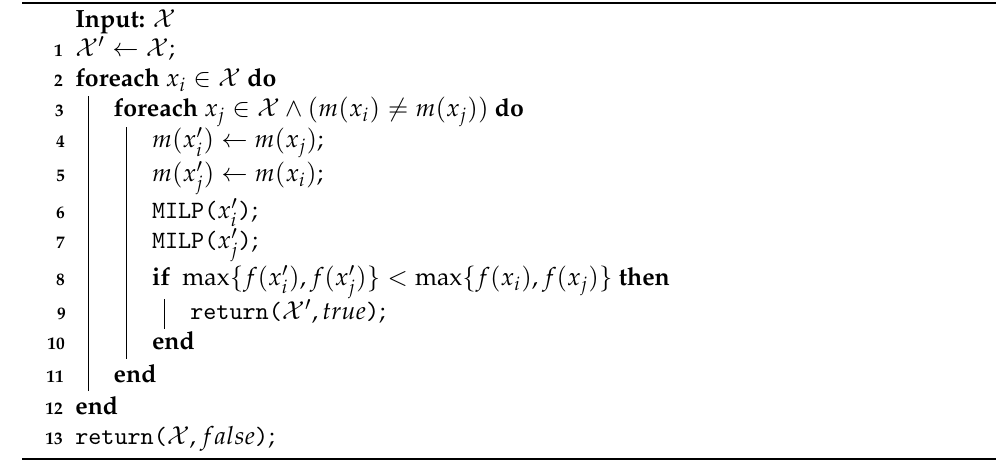
Algorithm 7: Unmanned air vehicles (UAV) Swap performed on EMR.